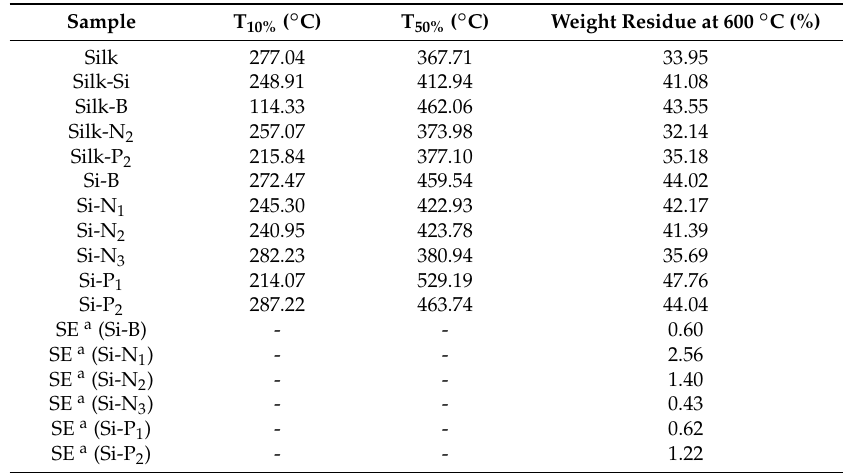
Figure 8. TG ( A , C ) and DTG ( B , D ) curves of Silk and Silk-P 1 , Silk-P 2 and Si-P 1 , Si-P 2 samples in nitrogen atmosphere. Table 4. TGA data in nitrogen atmosphere.